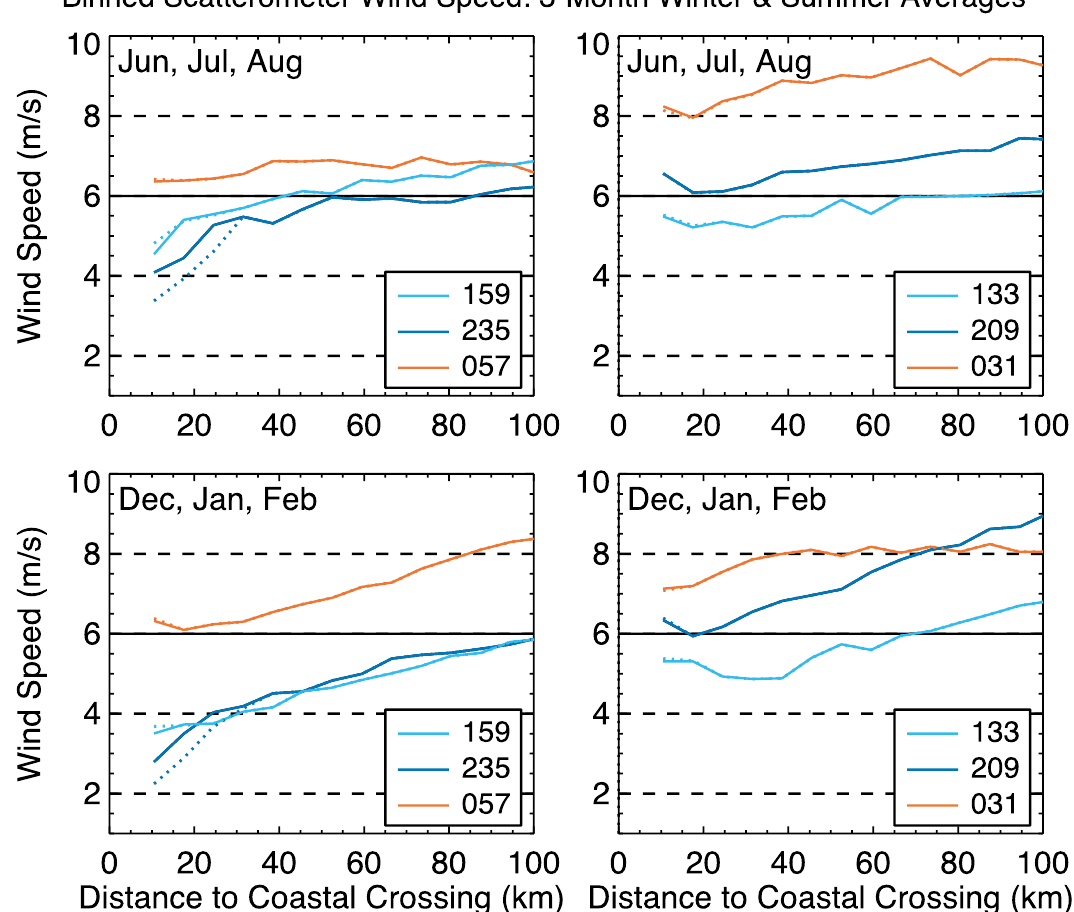
Figure 5. As in Figure 3, except showing QuikSCAT wind speeds binned into rectangular boxes (7 km by 13 km) arranged along the altimeter tracks as shown in Figure 2. Solid Lines: Retrievals marked as suspect by the PCP flag are excluded. Dotted Lines: All retrieved scatterometer L2 wind speed values within each rectangle are averaged. The x-axis shows the alongtrack distance from the box center to the nearest coastal crossing. Values for the box that would be touching the coast are not shown.